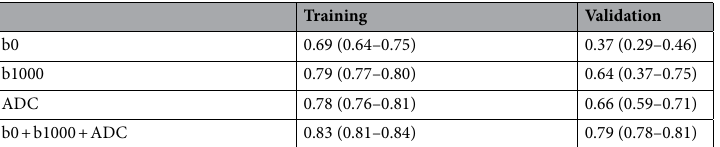
Table 2. Dice similarity coefficient with different sequences as input data for cross-validation. Data are presented as the mean and range of five cross-validation models. ADC apparent diffusion coefficient map, DSC dice similarity coefficient.